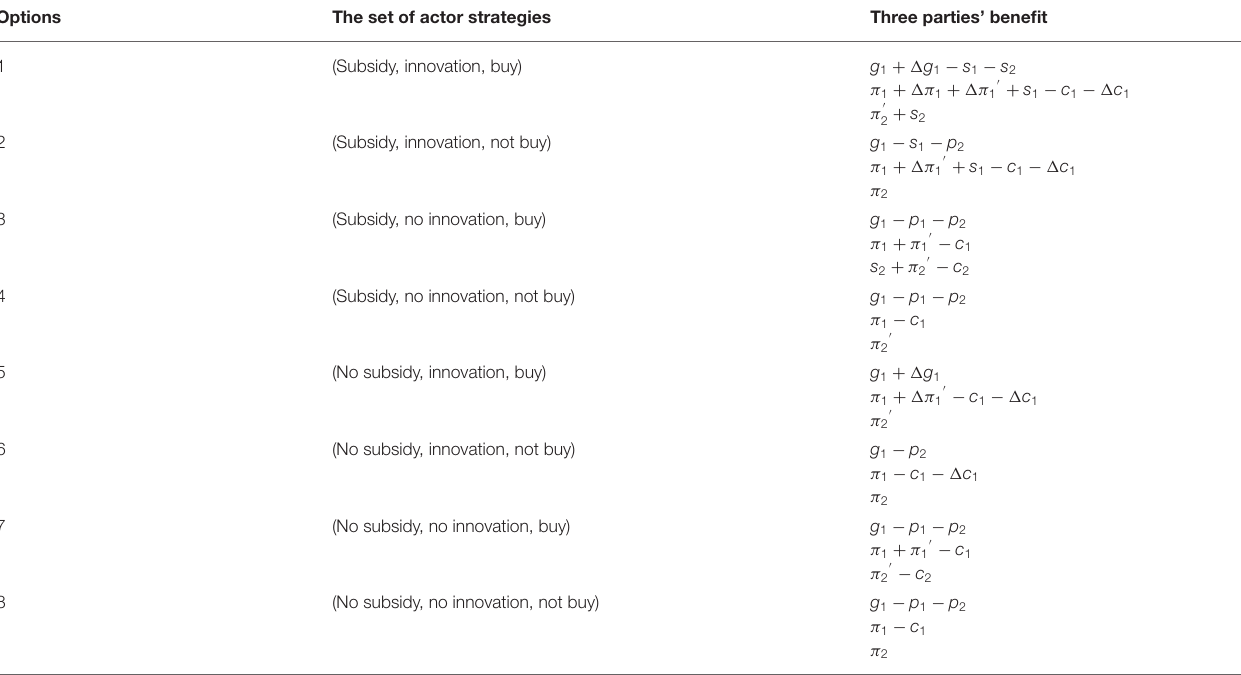
TABLE 1 | Revenue matrix of government, enterprises and consumers. Options The set of actor strategies Three parties’ benefit